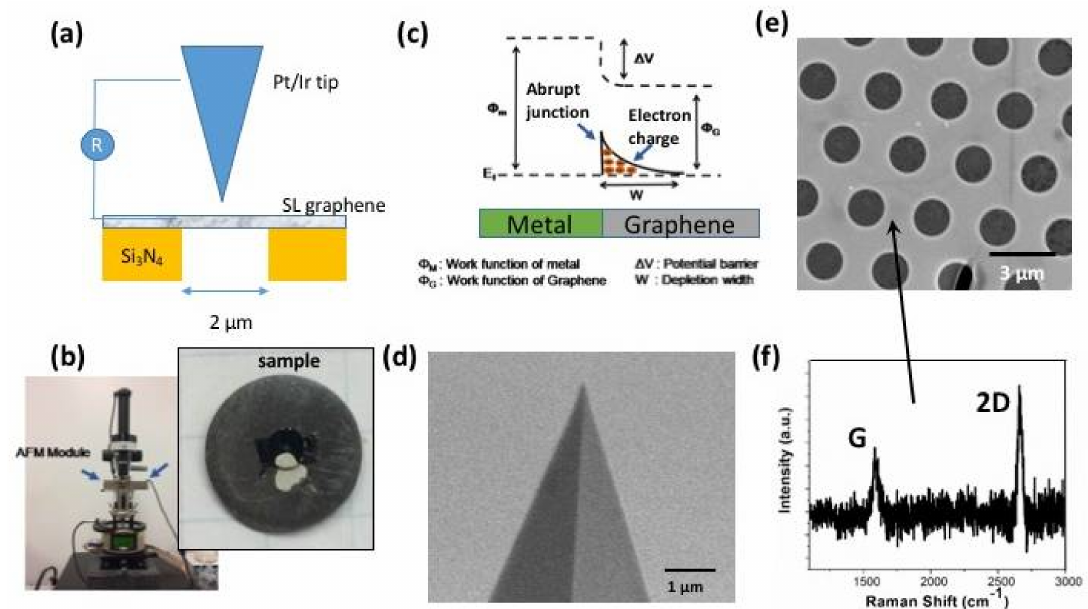
Figure 1. Summary of the experimental setup. ( a ) Schematic of the AFM measurements of electrical contact evolution for Pt/Ir tip and graphene performed for free-standing and supported graphene and ( b ) photograph of the sample assembly. ( c ) Metal–graphene band diagram for the contact. ( d ) SEM image of the conductive AFM tip. ( e ) SEM image of the single layer graphene transferred on a silicon nitride substrate with holes. ( f ) Raman analysis confirming single layer graphene presence after the graphene